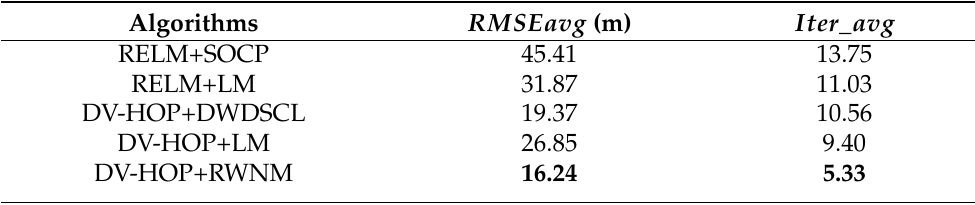
Table 8. RMSEavg and Iter _ avg at different levels of outliers Θ from 0% to 50%, R = 45 m and nfe = 0.1 under anisotropic networks, the best performances in RMSE average and iteration average are denoted in bold